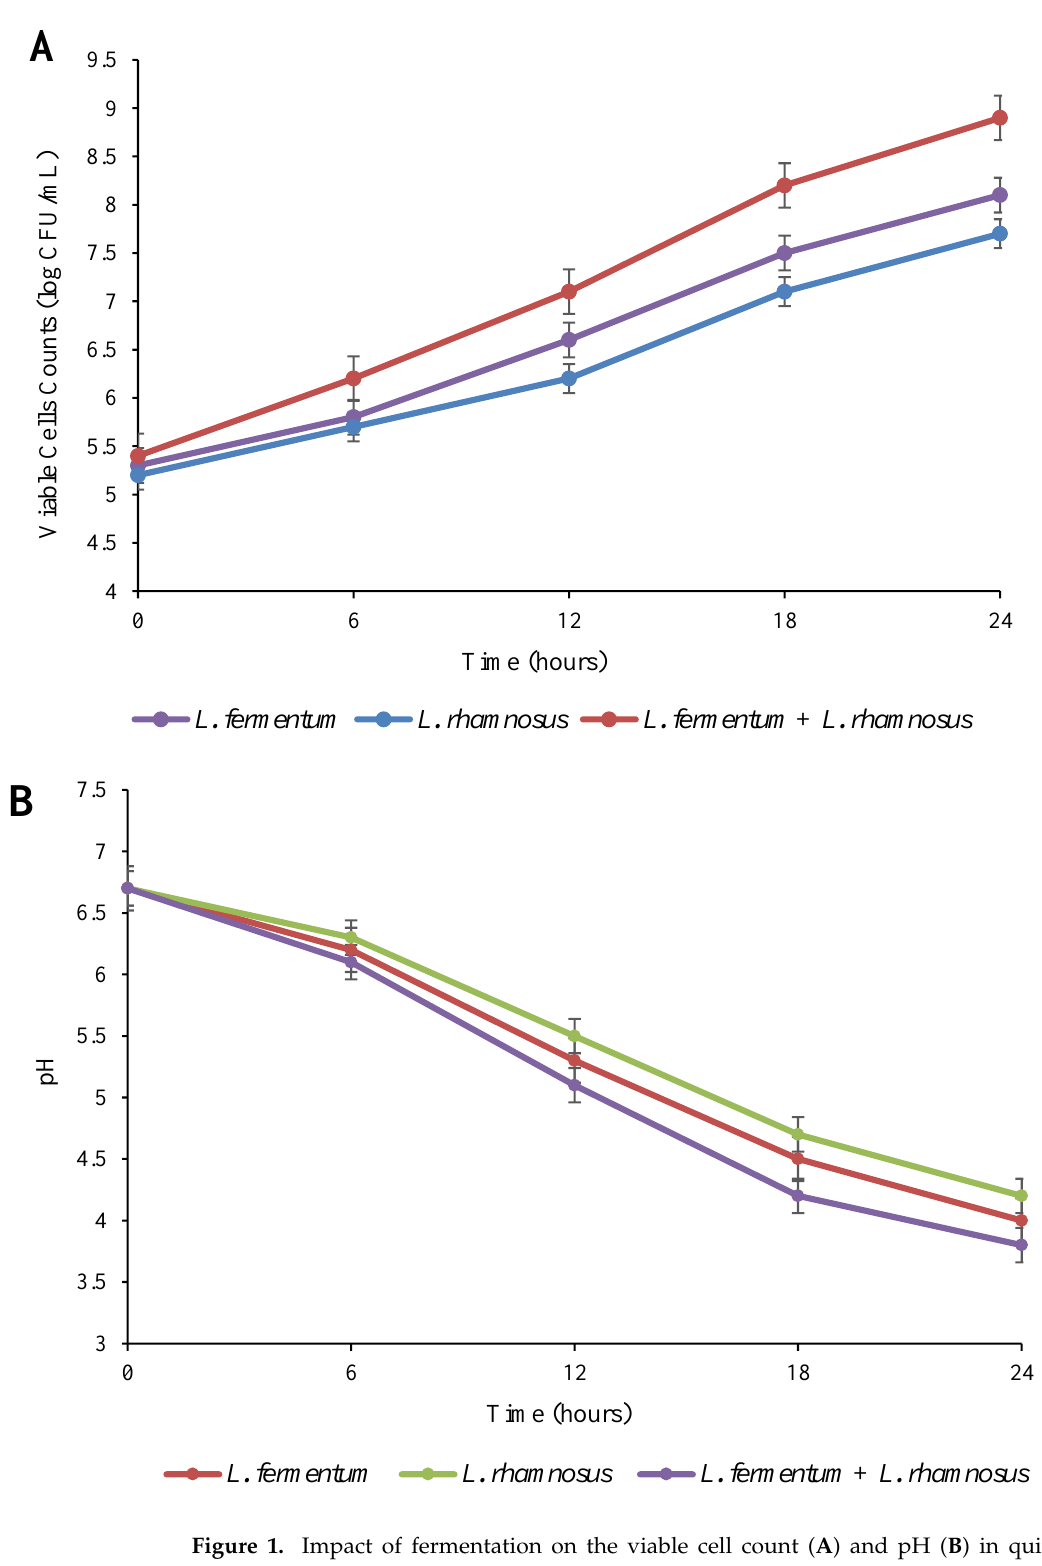
Figure 1. Impact of fermentation on the viable cell count ( A ) and pH ( B ) in quinoa seed fermented by pure and binary mixed cultures of two Lactobacillus species. The error bars reveal the standard deviation of each measurement in quinoa seed over 24 h of fermentation. L. rhamnosus : Lacticaseibacillus rhamnosus monoculture; L. fermentum : Limosilactobacillus fermentum monoculture; L. rhamnosus + L. fermentum : binary co-cultures of L. rhamnosus and L. fermentum.